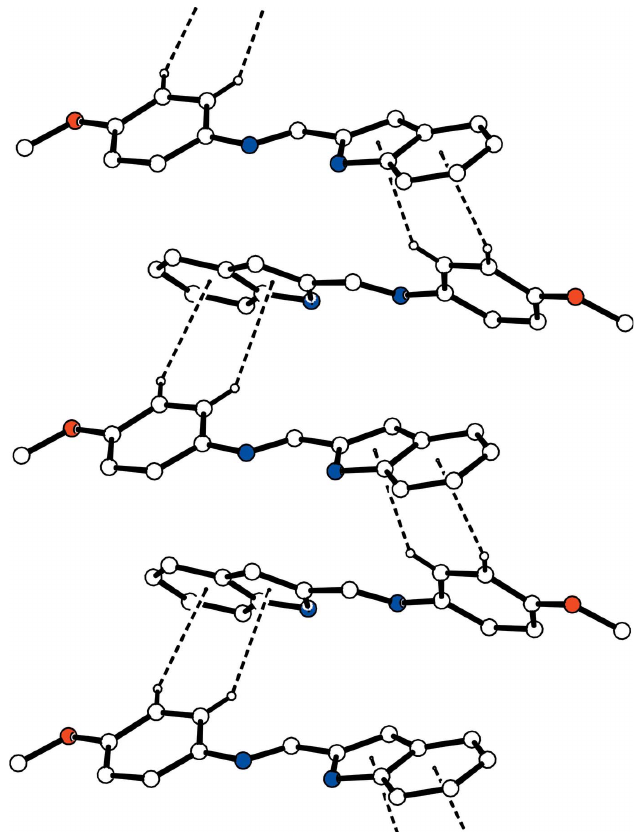
Figure 2 One-dimensional column structure in the crystal of the title compound viewed along the a axis. The C—H (cid:2)(cid:2)(cid:2) O hydrogen bonds and the C— H (cid:2)(cid:2)(cid:2) (cid:2) interactions are shown as dashed lines. H atoms not involved in these interactions are omitted for clarity.